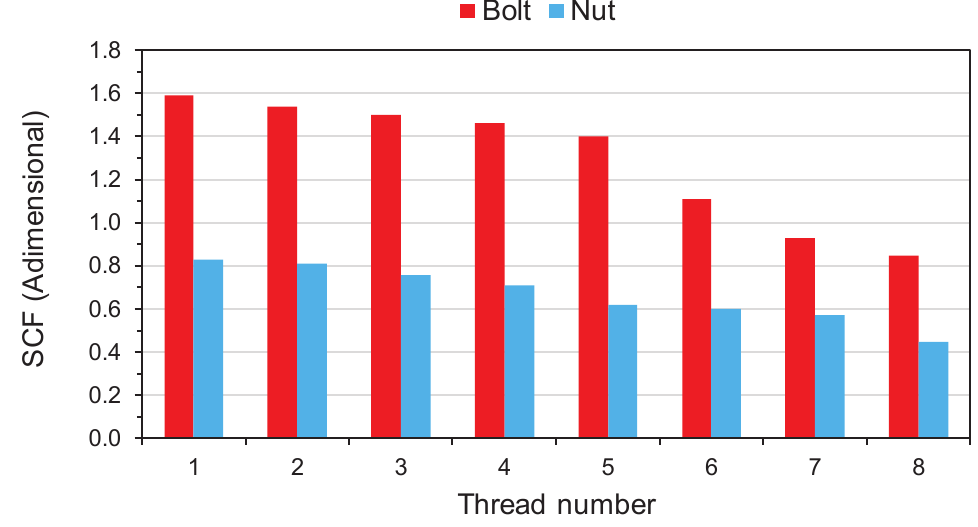
Figure 9. Stress concentration factor across the root of the bolt threads based on the maximum stress values .